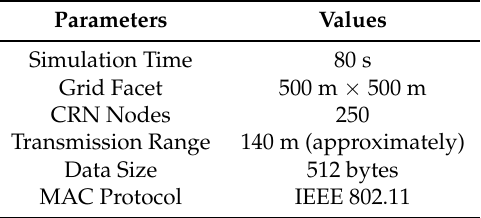
Table 1. Simulation parameters.